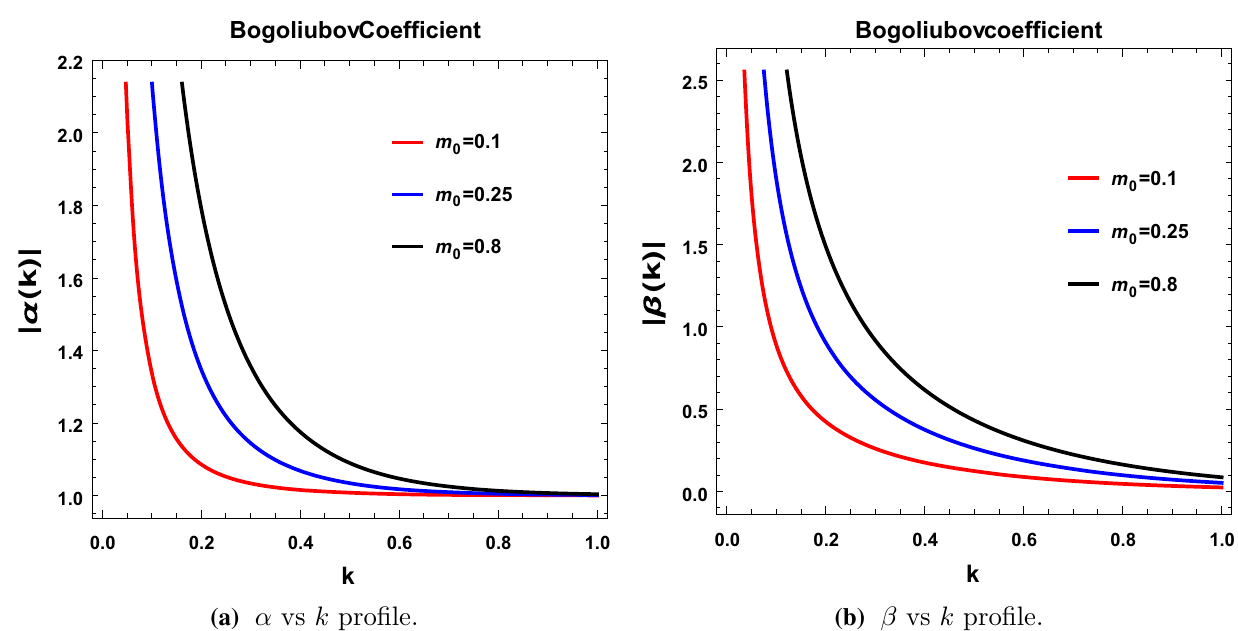
Fig. 11 Wave number dependence of the Bogoliubov coefficients are shown here for mass profile II. Here we fix ρ = 1